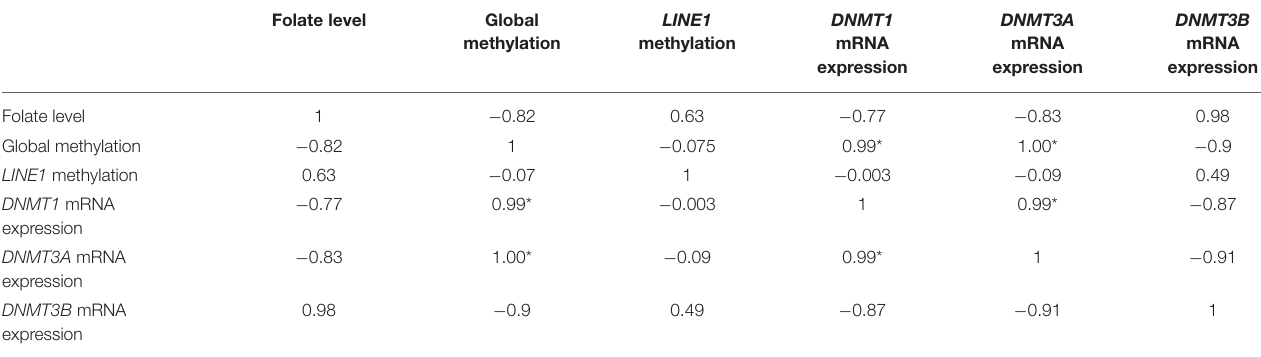
TABLE 3 | Correlation analysis of mRNA expression of various DNMTs, folate level, and global methylation level in HTR-8/SVneo cells upon folic acid supplementation.